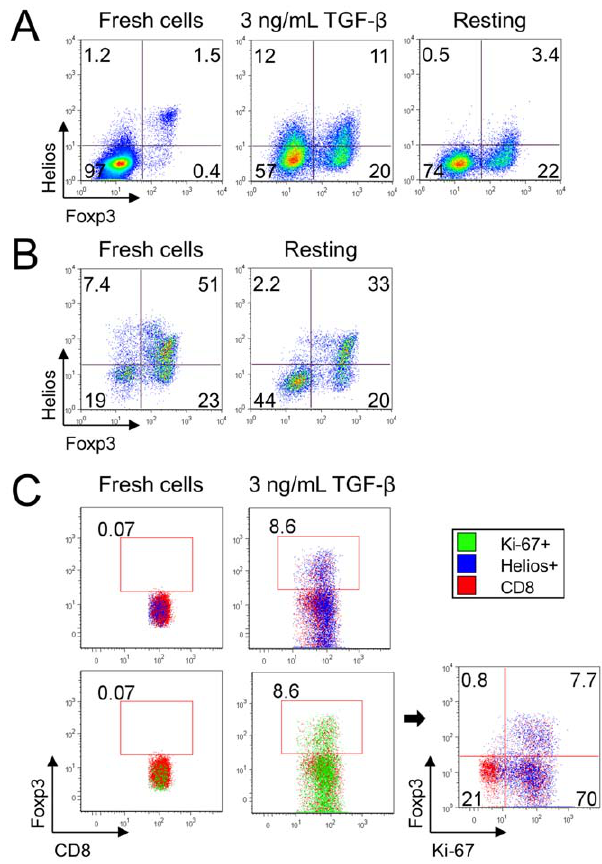
Figure 7. Helios is not associated with Treg lineage commit- ment in mice. (A) Murine CD4 + CD25- Teffs stimulated with CD3/CD28 mAbs, IL-2 and TGF-beta to become iTregs upregulated Helios in both Foxp3 + and Foxp3- subsets (middle). Withdrawal of TCR stimulation and TGF-beta led to loss of Helios expression (right). (B) Murine Tregs after isolation (left) and after 4 d with IL-2 but without stimulation (right). In resting conditions Helios expression decreased, and Foxp3 expression by Tregs decreased mainly in the Helios + subset. (C) Induction of Foxp3 in mouse CD8 + cells in the same conditions as in (A). Foxp3 + converted CD8 cells co-expressed Helios and